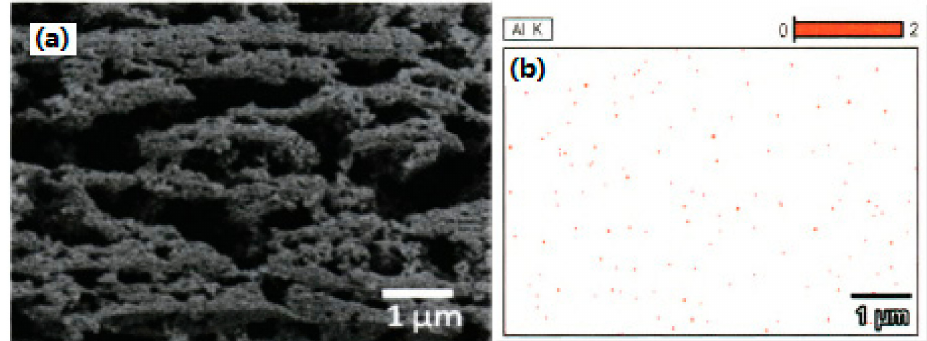
Figure 4. Al elements distribution of Al / NC nano-composite (Al / NC = 1:2) by EDS analysis. ( a ) Selected area of Al / NC nano-sized composite; ( b ) Al elements’ distribution. Reproduced from [33], with permission from Han Neng Cai Liao,